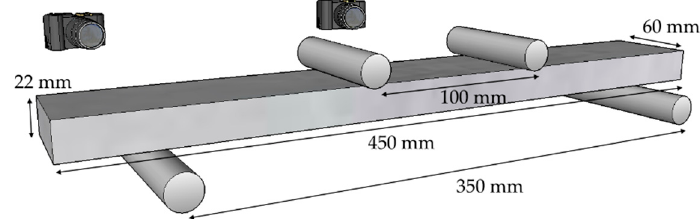
Figure 6. Tensile test setup